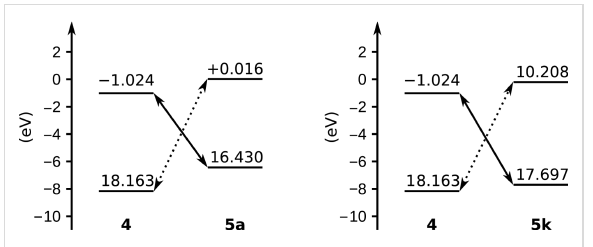
Figure 5: FMO energy levels of dipole 4 and dipolarophiles 5a and 5k calculated at the B3LYP/6-31G* level. Continuous and dotted lines indicate the favored ( Δ E = 5.407 eV for 5a and 6.673 eV for 5k ) and the disfavored ( Δ E = 8.178 eV for 5a and 7.955 eV for 5k ) molecular orbital interactions, respectively.